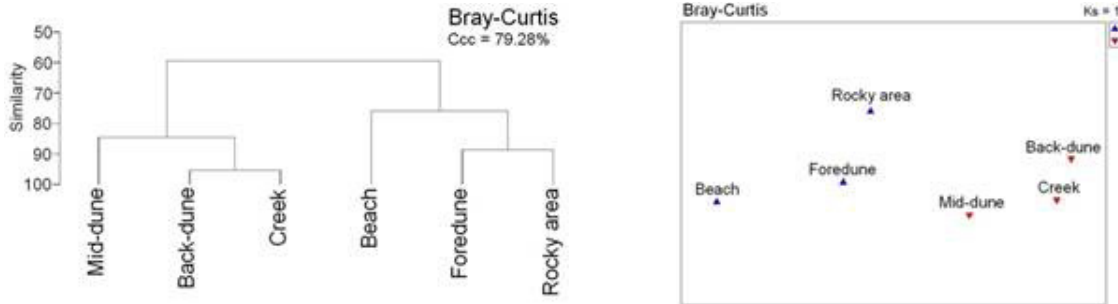
Figure 3. Similarity according to plant categories (native, apophyte and alien) using Bray-Curtis index. Left: Dendrogram. Right: Scatter plot graph. Ccc - Cophenetic correlation coefficient; Ks - Kruskal’s stress.